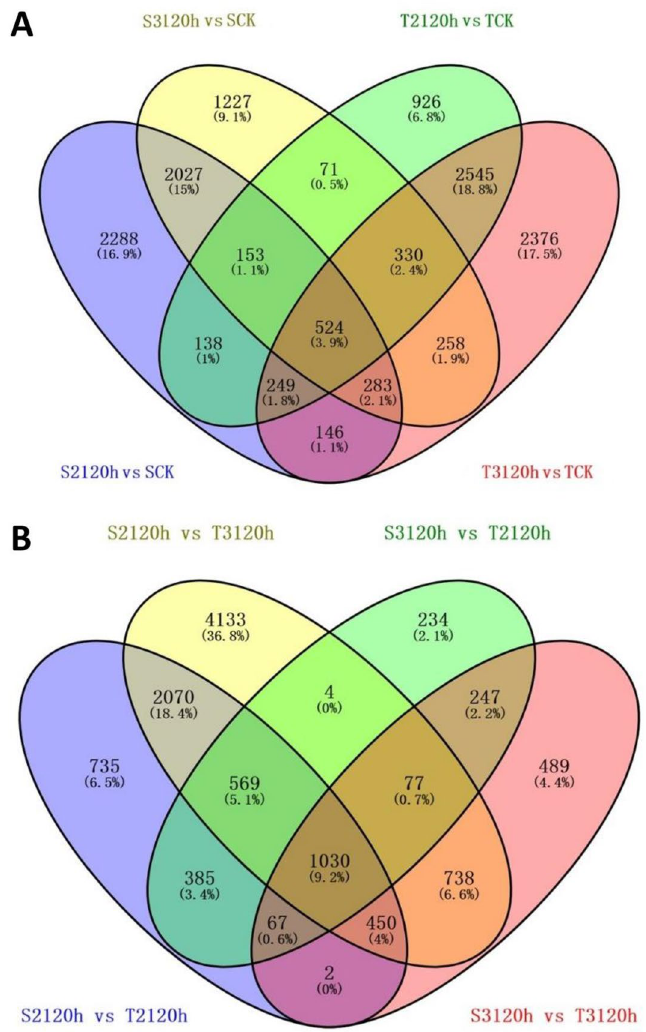
Figure 3. Venn diagram showing overlap of genes of G. hirsutum in response to V. dahliae . ( A ) Venn diagram showing overlap of up-regulated genes between the treatment groups and their respective control groups. ( B ) Overlap genes between the two treatment groups of in response to V. dahliae